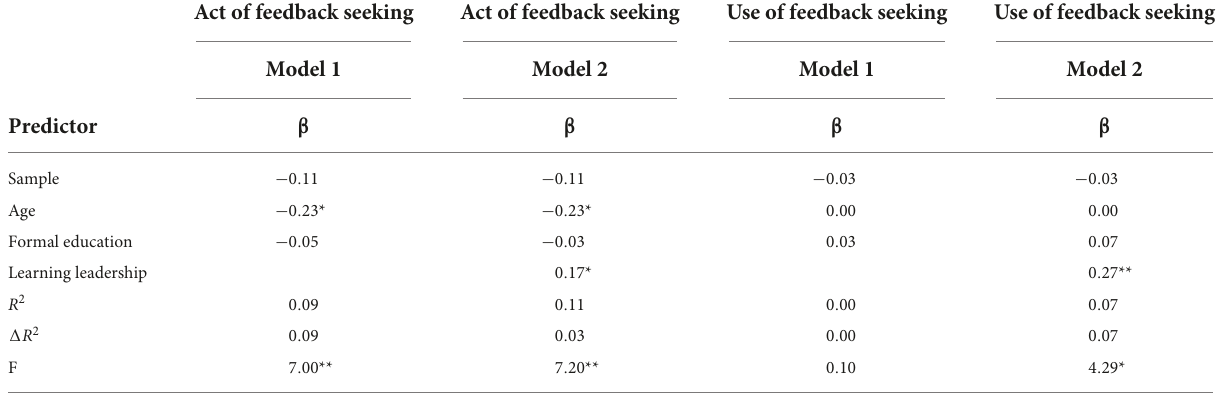
TABLE 5 Regression results for the effects of learning leadership on feedback seeking. Act of feedback seeking Use of feedback seeking